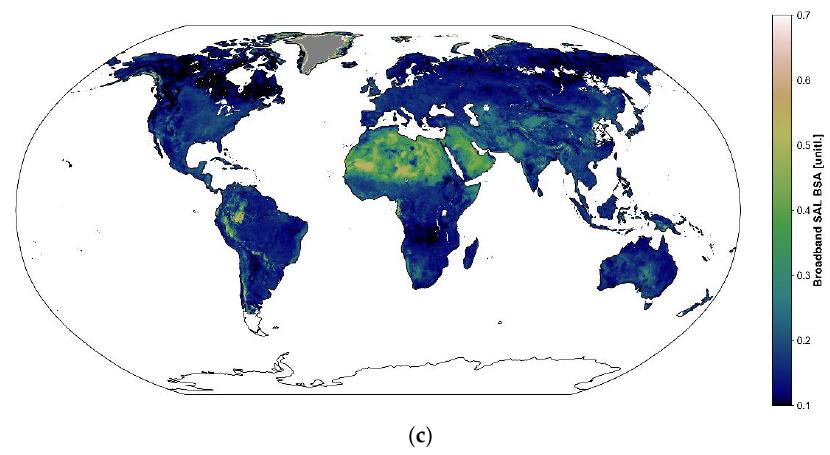
Figure 4. The comparison of global retrieval coverage from 2010 for ( a ) the SCM demonstrator, 10-day period from DOY 190, ( b ) the MCD43D, 16-day sampling period centered on DOY 195, full BRDF inversions shown only, and ( c ) the 10-day average from two CLARA-A2-SAL pentad means starting from DOY 190. The ocean and sea ice albedo have been masked in CLARA-A2-SAL for clarity. Grey indicates albedo estimates with values above 0.7.